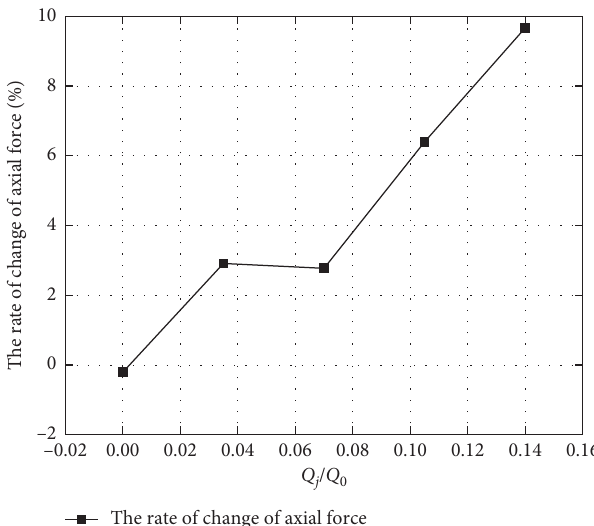
Figure 18: The growth rate of the nozzle axial force under different jet flow